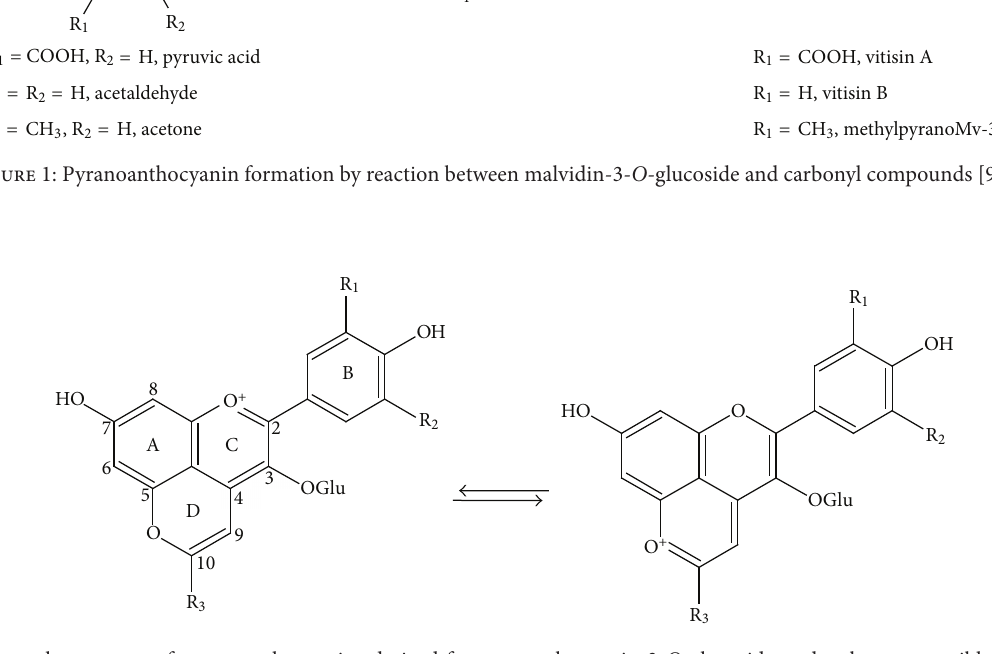
F 2: General structures of pyranoanthocyanins derived from an anthocyanin-3- O -glucoside under the two possible ions �avylium [9, 60].